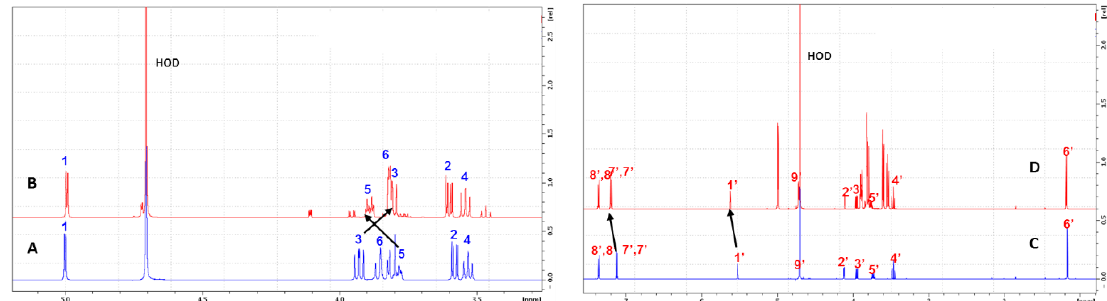
Figure 3. Partial proton nuclear magnetic resonance ( 1 H-NMR) spectra (5 mM in D 2 O) of α-CD in the absence ( A ) and in the presence of MOR ( B ) recorded at 600 MHz at 300 K and of MOR in the absence ( C ) or in presence of α-CD ( D ).